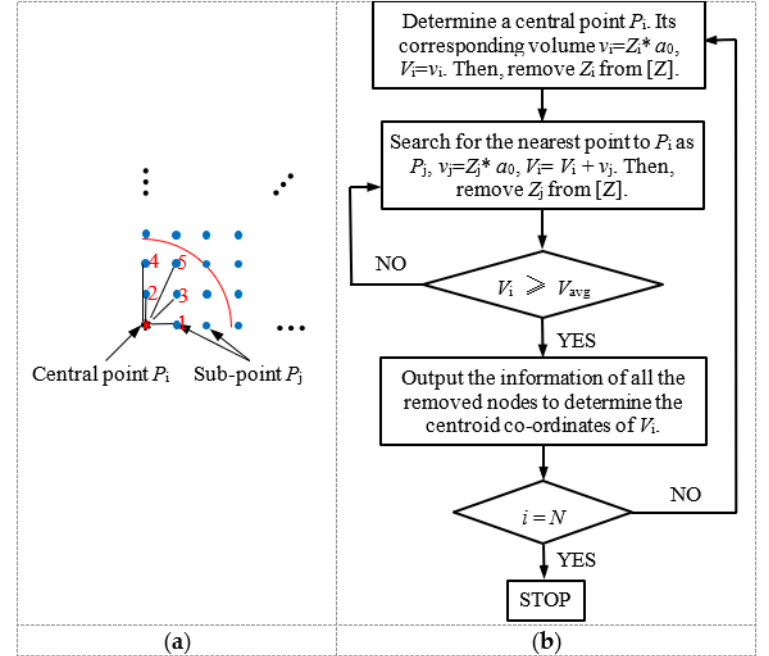
Figure 2. Central search method: ( a ) divide V T ; ( b ) flowchart of CSM .